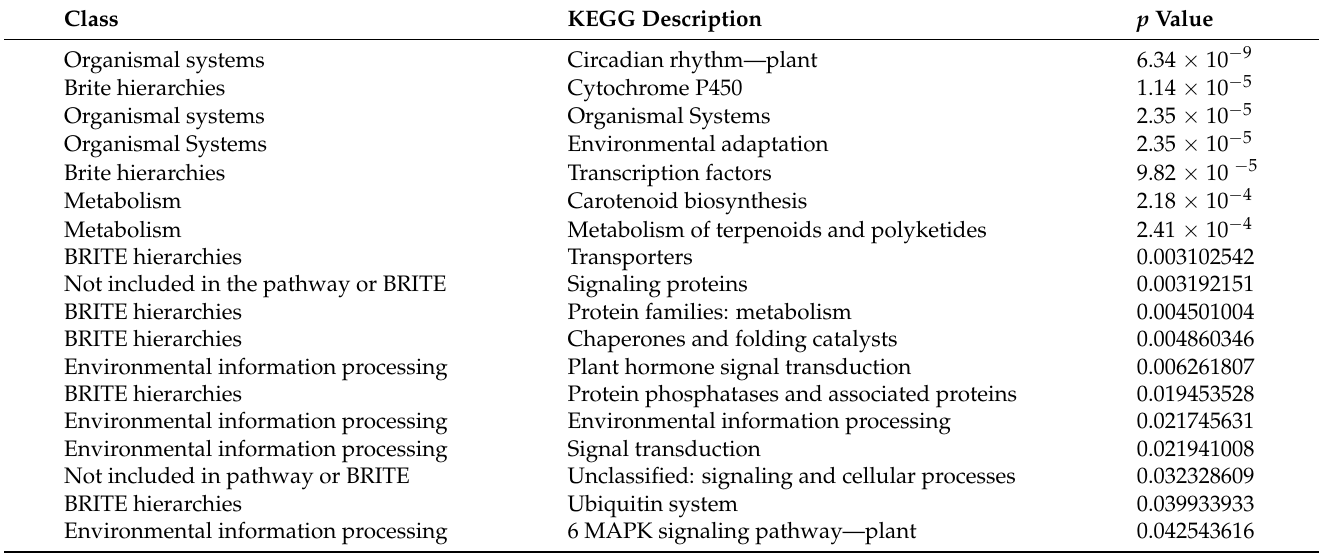
Table 3. KEGG enrichment analysis of common